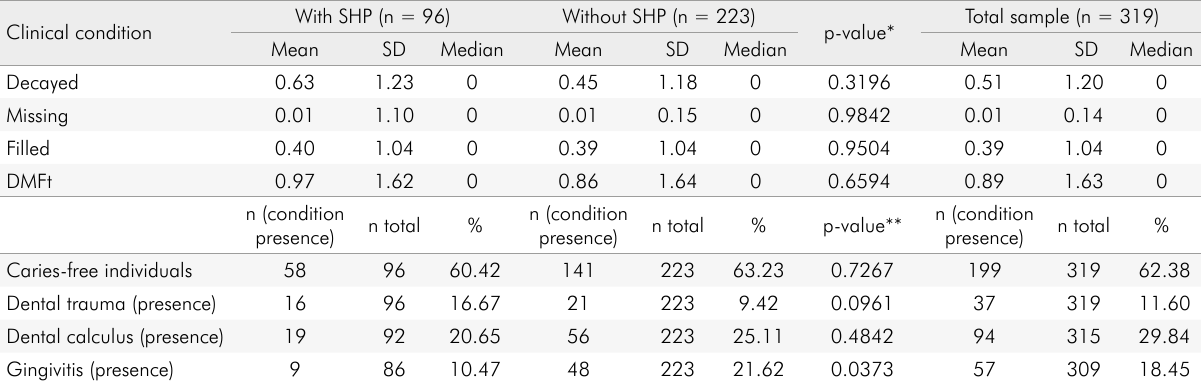
Caries-free individuals